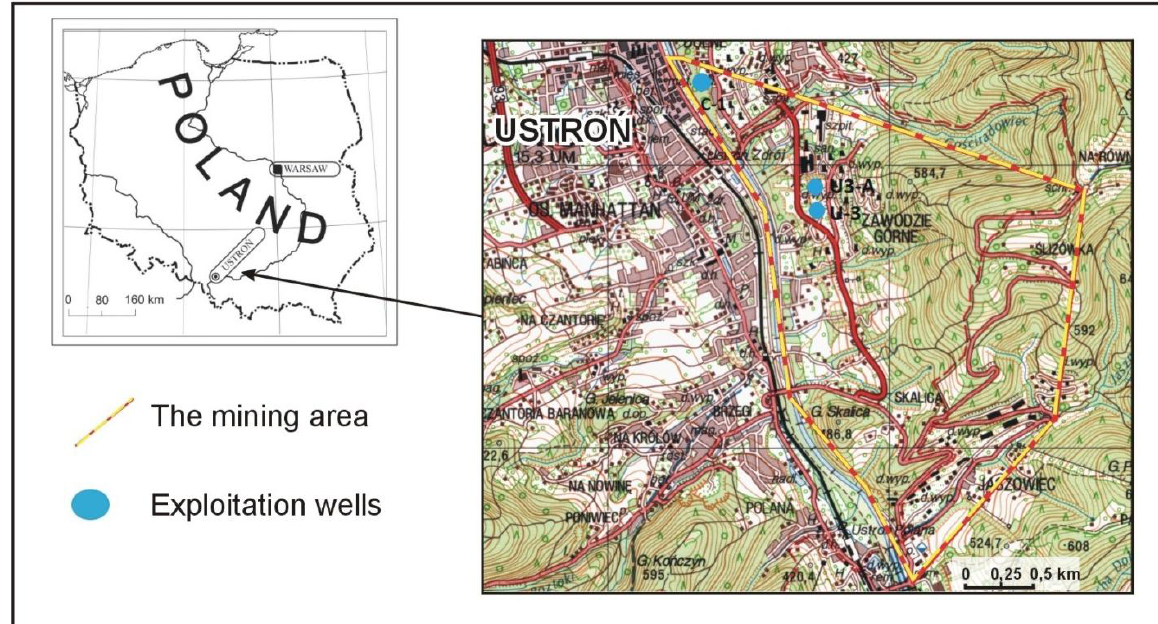
Fig. 1. Location of the study